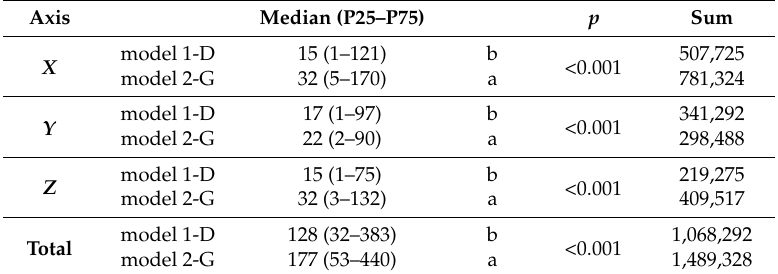
Table 6. Comparison of the values of the square of the X-deviation, Y-deviation, Z-deviation, and the total in the impressions of the groups using the 3M™ True Definition Scanner, without and with angulation (groups D and G,